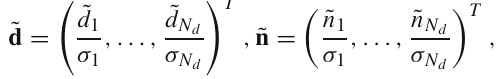
Fig. 1. The condition | h L | / | h R | ∈ ( 1 / 3 , 3 ) requires that ι ∈ ( 74 ◦ , 106 ◦ ) . Considering this fact and assuming the